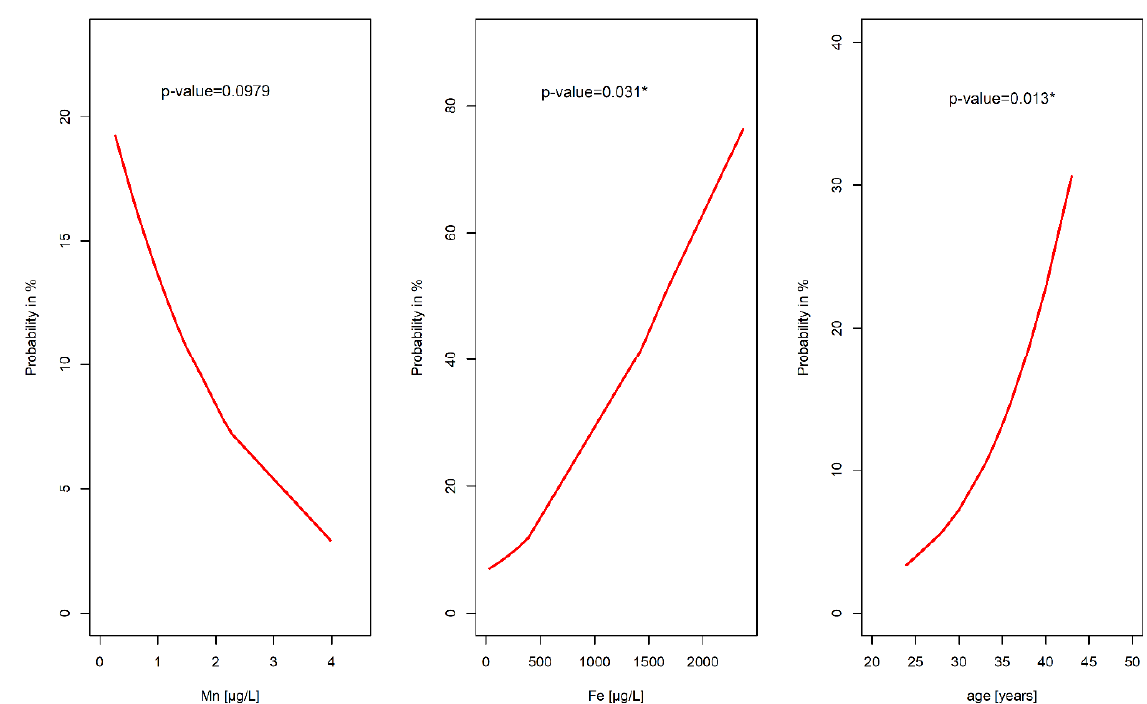
Figure 3. The probability of fetal chromosomal abnormalities in relationship with the concentrations of Mn and Fe in the amniotic fluid and with the maternal age; * statistically significant relationships at the level of α = 0.05.